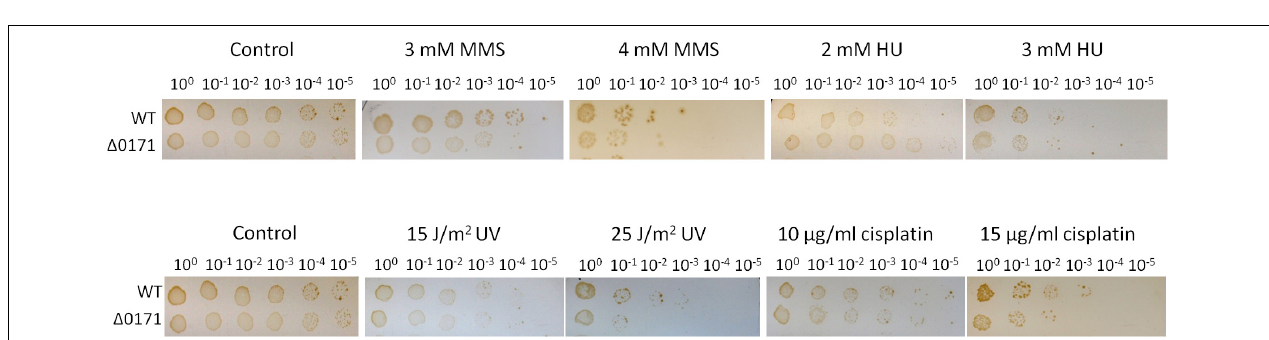
FIGURE 6 | SiRe_0171 deletion mutants are more sensitive to higher doses of UV and cisplatin. The method for DNA damaging agent sensitivity assay was the same as that in Figure 4 . The experiments were performed for three times. Representative figures are